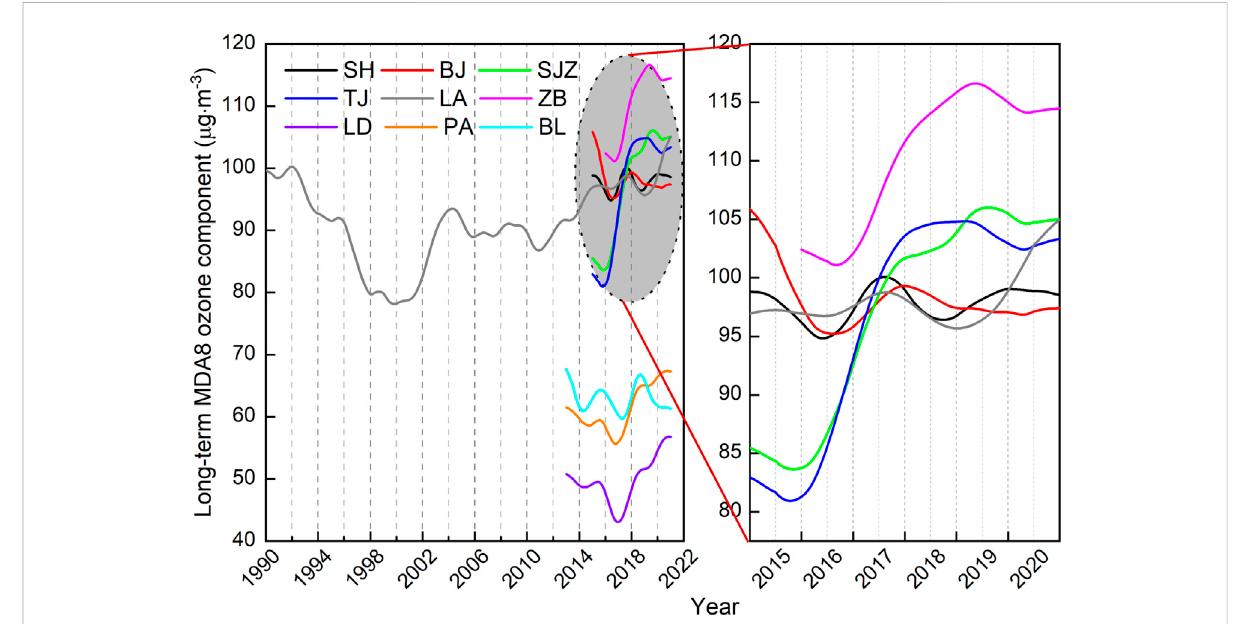
FIGURE 4 Evolution of urban surface MDA8 ozone levels in different cities. SH, Shanghai, BJ, Beijing, SJZ, Shijiazhuang, TJ, Tianjin, LA, Los Angeles, ZB, Zibo, LD, London, PA, Paris, BL, Berlin.